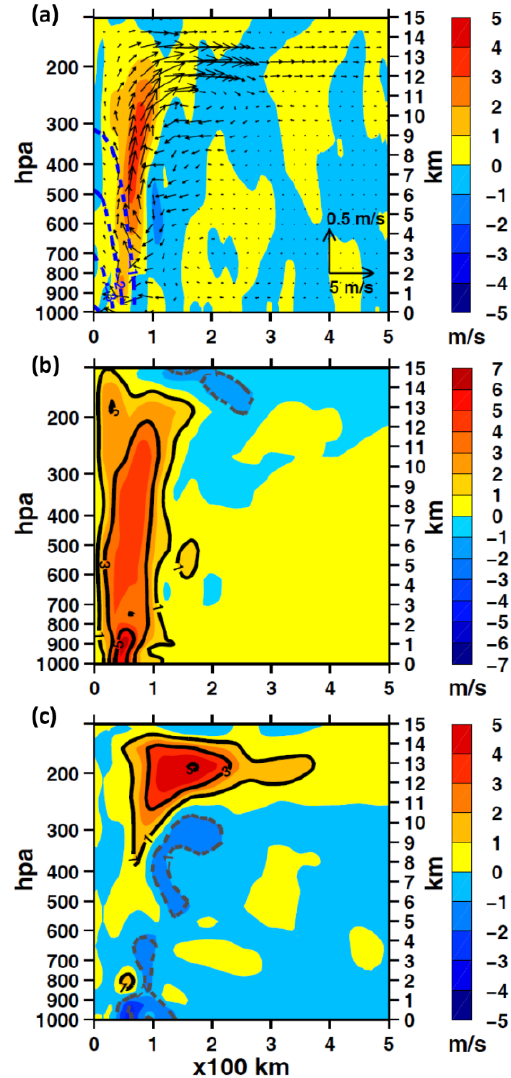
Figure 4. Ensemble mean differences (eddy minus control = ∆ ) of various fields in azimuthally averaged radial and vertical section at day 5: ( a ) pressure ∆ p (blue contours, hPa) and radial and vertical velocity ( ∆ u, ∆ w) vectors superposed on color shading of vertical velocity ∆ w ( × 10); ( b ) azimuthal velocity ∆ v (positive into page) and ( c ) radial velocity ∆ u (positive outward) (m/s). A total of 39 members in the upper-quartile of intensity were used to construct this plot. Values of | ∆ w| (cid:46) 0.1 m/s, | ∆ v| (cid:46) 0.63 m/s, | ∆ u| (cid:46) 0.6 m/s, and | ∆ p| (cid:46) 0.7 hPa, are not significant at the 95% confidence level based on the nonparametric Wilcox-Mann-Whitney test